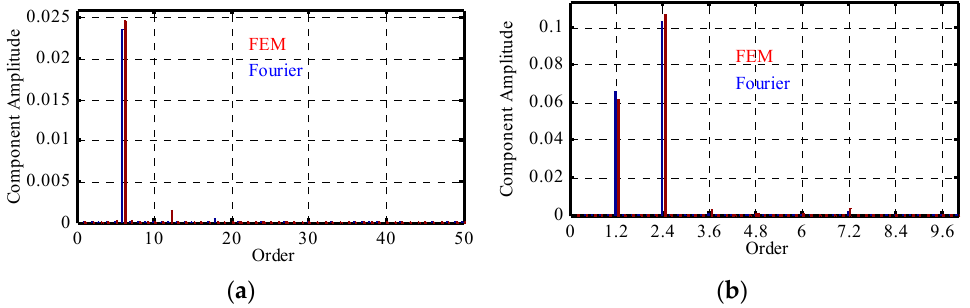
Figure 11. Spectrum of magnetic flux density computed in the rotor moving frame: ( a ) Qs48p8, ( b ) Qs36p15.